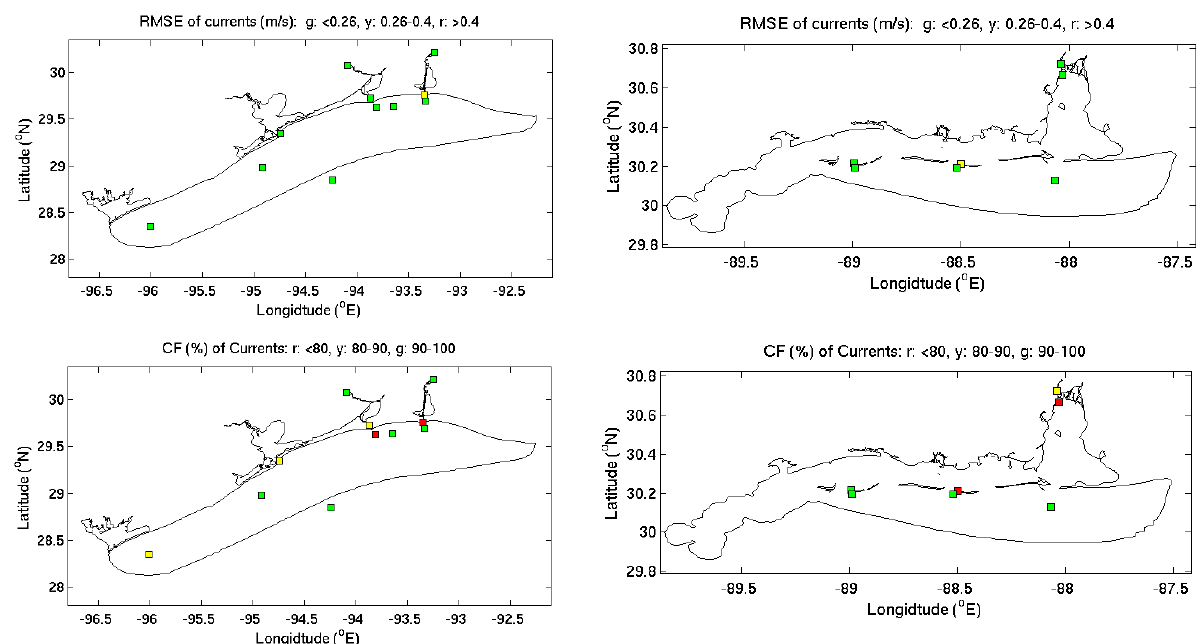
Figure 12. Hindcast current velocity RMSE and CF skill assessment summary map for NWGOFS (left column) and NEGOFS (right column).